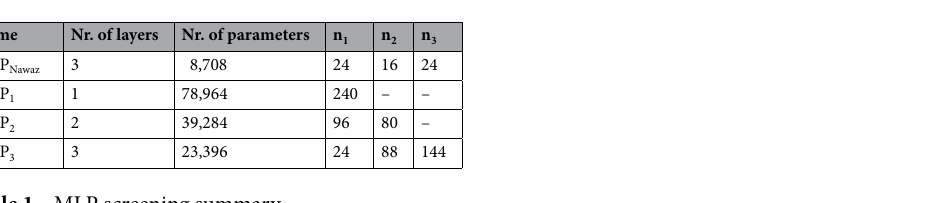
Table 1. MLP screening